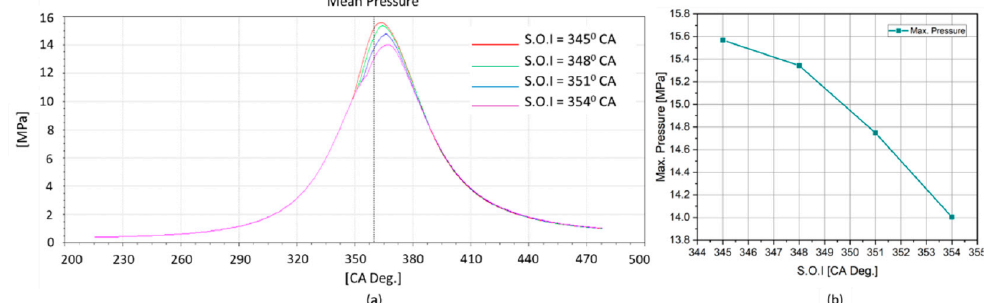
Figure 20. In-cylinder pressure diagrams ( a ) and maximum pressure ( b ) according to the change of the pilot S.O.I angle in the dual-fuel mode.